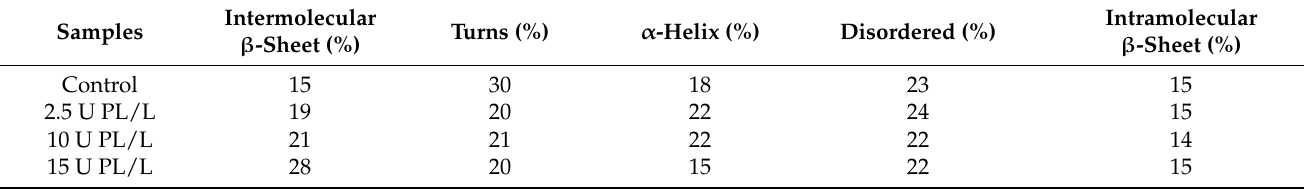
Table 3. Secondary structure analysis of amide I region obtained by Fourier-transform infrared spectroscopy from UHT skim milk stored at 23 ◦ C for three